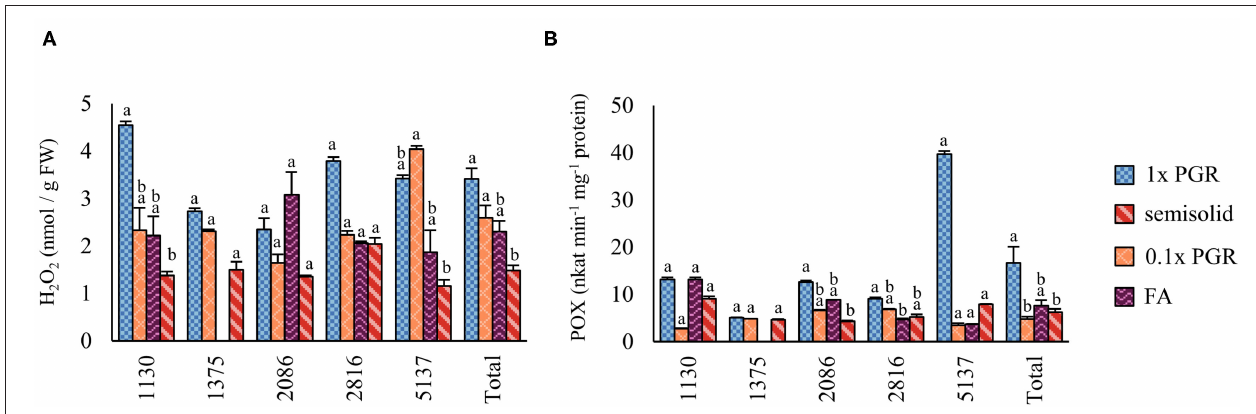
FIGURE 2 | Oxidative stress analysis results for Experiment IV as represented by (A) hydrogen peroxide (H 2 O 2 ) content and (B) guaiacol peroxidase (POX) enzyme activity. Mean values are presented with error bars representing the SEM. Significant differences between treatments within lines or overall (Total) are marked with different